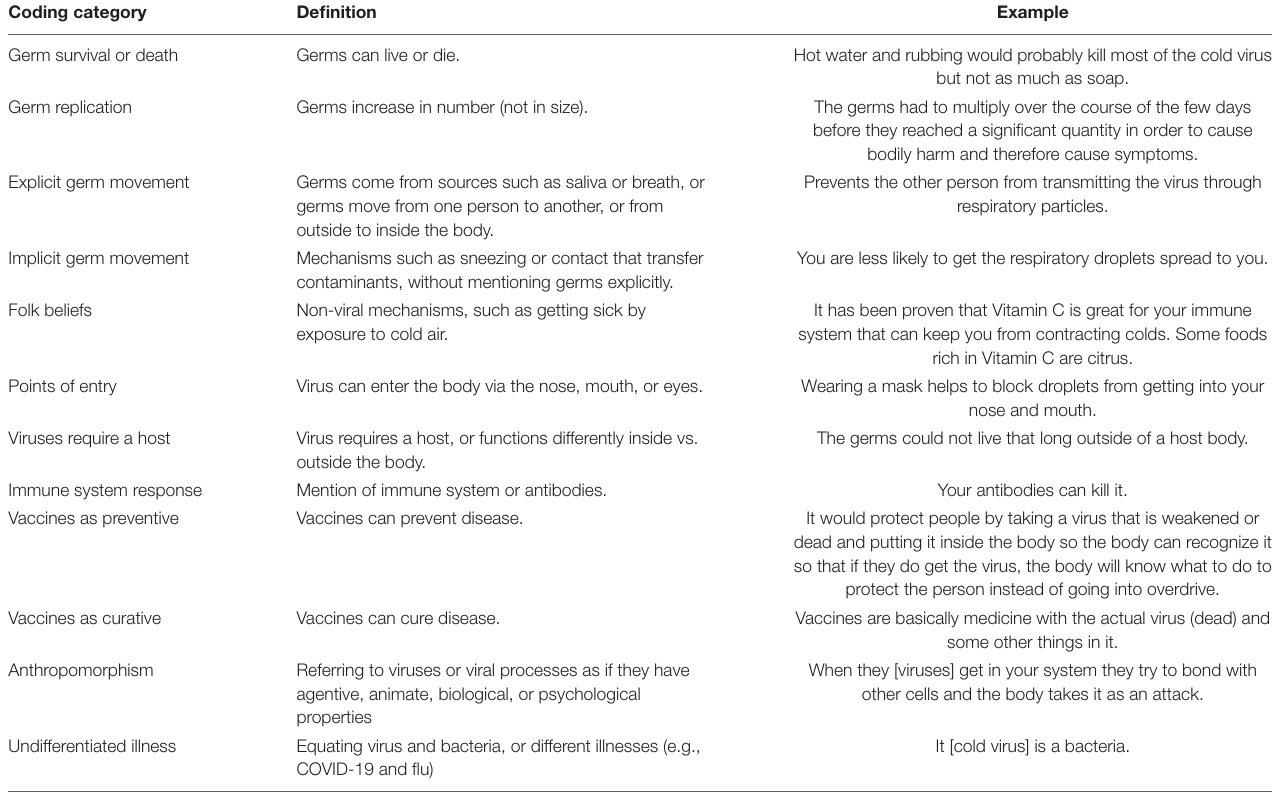
TABLE 2 | Qualitative coding, coding categories and examples. Coding category Definition